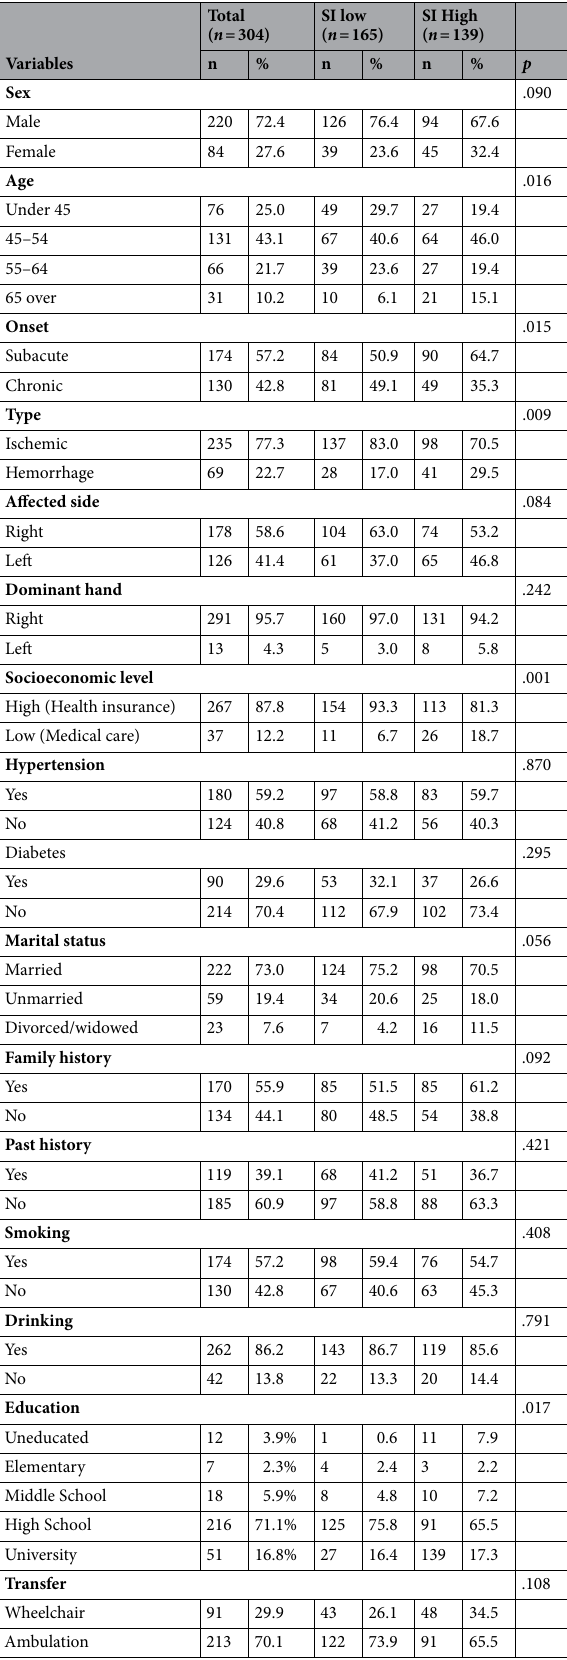
Table 1. Demographic and clinical characteristics based on suicidal ideation. Abbreviation: SI, suicidal